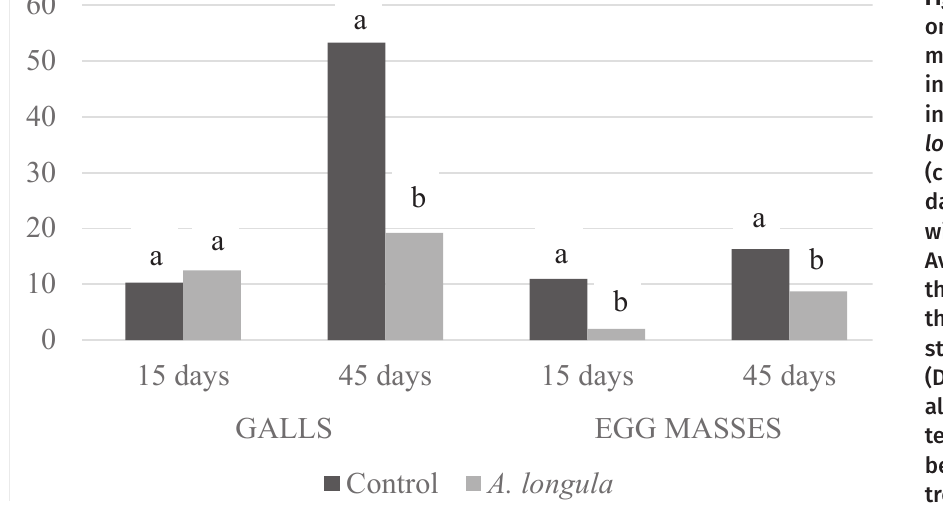
Figure 1. Number of galls on the roots and egg masses of M. enterolobii in guava seedlings inoculated with A. longula or without AMF (control), at 15 and 45 days after inoculation with M. enterolobii. Averages followed by the same letter (down the columns) are not statistically signifi cant (Duncan’s post-hoc test, alpha of 0.05). Post-hoc test was performed between the same day